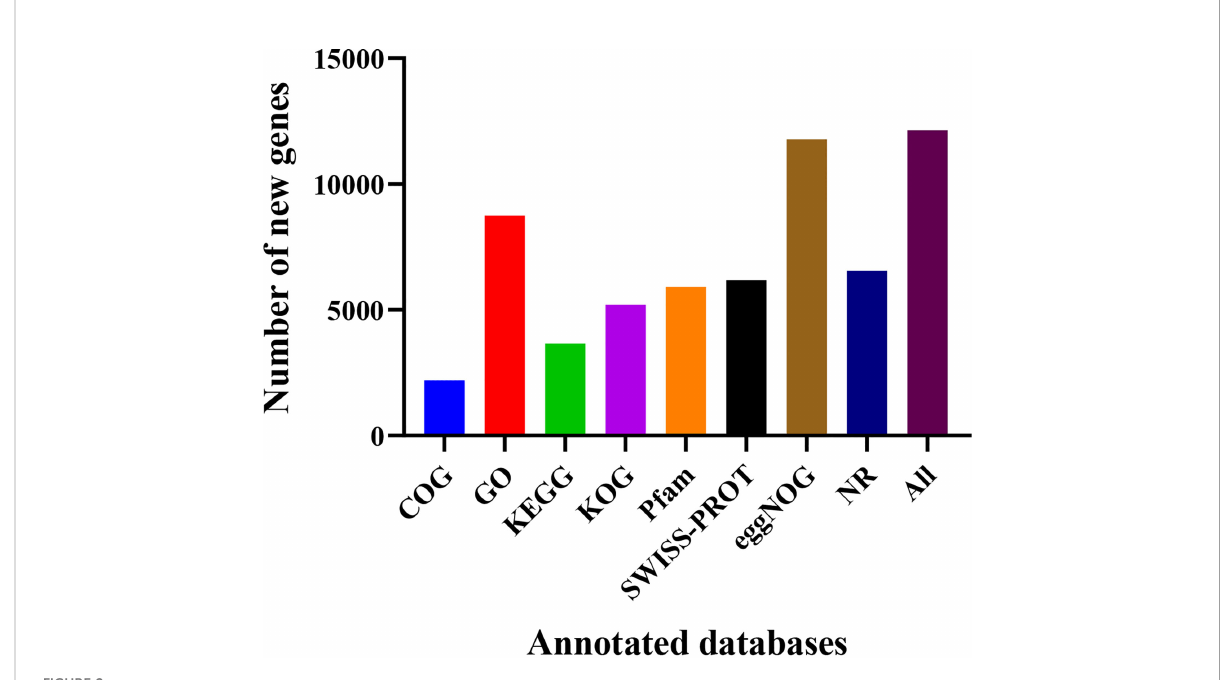
FIGURE 2 Number of new genes functionally annotated in various